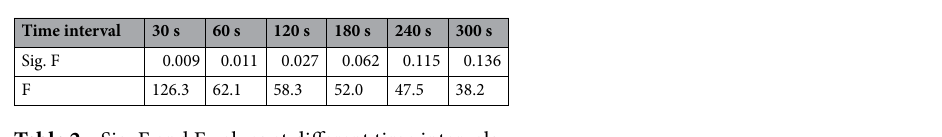
Table 2. Sig. F and F values at different time